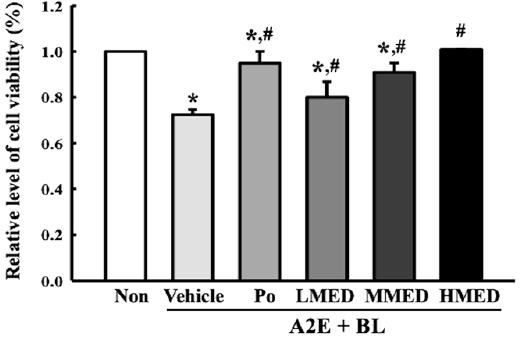
Figure 4. Determination of cell viability in MED + A2E + BL treated ARPE19 cells. After pretreatment of three different dosage MED for 24 h, their viability was determined using MTT assay. Two to three wells per group were used for the MTT assay, and optical density was measured in duplicates. All values in results are represented as the means ± standard deviation (SD). * indicated statically significance compared to the Non treated group, while # indicated statically significance compared to the Vehicle + A2E + BL treated group. Abbreviations: MTT, 3-(4,5-dimethylthiazol-2-yl)-2,5-diphenyltetrazolium bromide; MED, methanol extracts of Dipterocarpus tuberculatus Roxb.; A2E: N-retinylidene-N-retinylethanolamine; BL, Blue light.